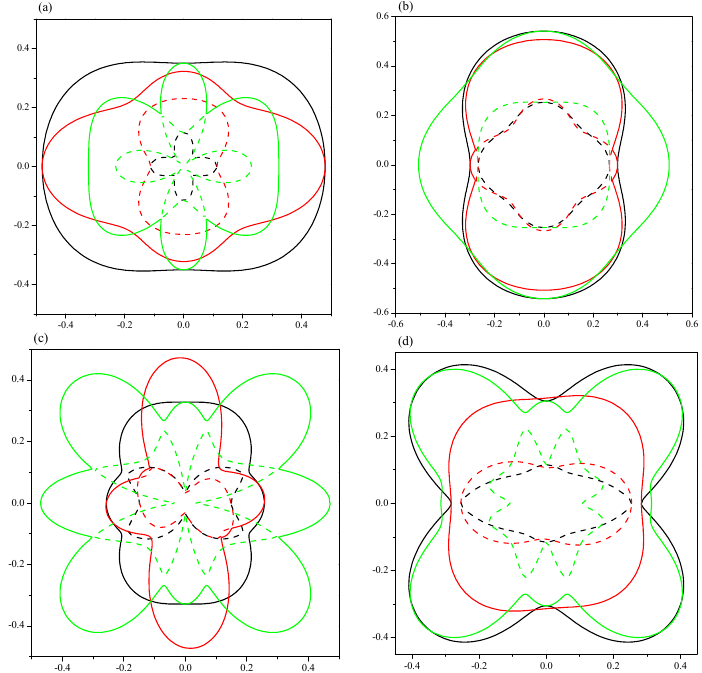
Figure 8. 2D representations of Poisson’s ratio. ( a ) Pnma -Ca 2 C at 0 GPa; ( b ) Pnma -Ca 2 C at 100 GPa; ( c ) C 2/ m -Ca 2 C at 0 GPa; ( d ) C 2/ m -Ca 2 C at 6 GPa. The solid and dash lines represent the maximal and minimal positive values, respectively. The black, red and green lines represent the xy , xz and yz planes, respectively.